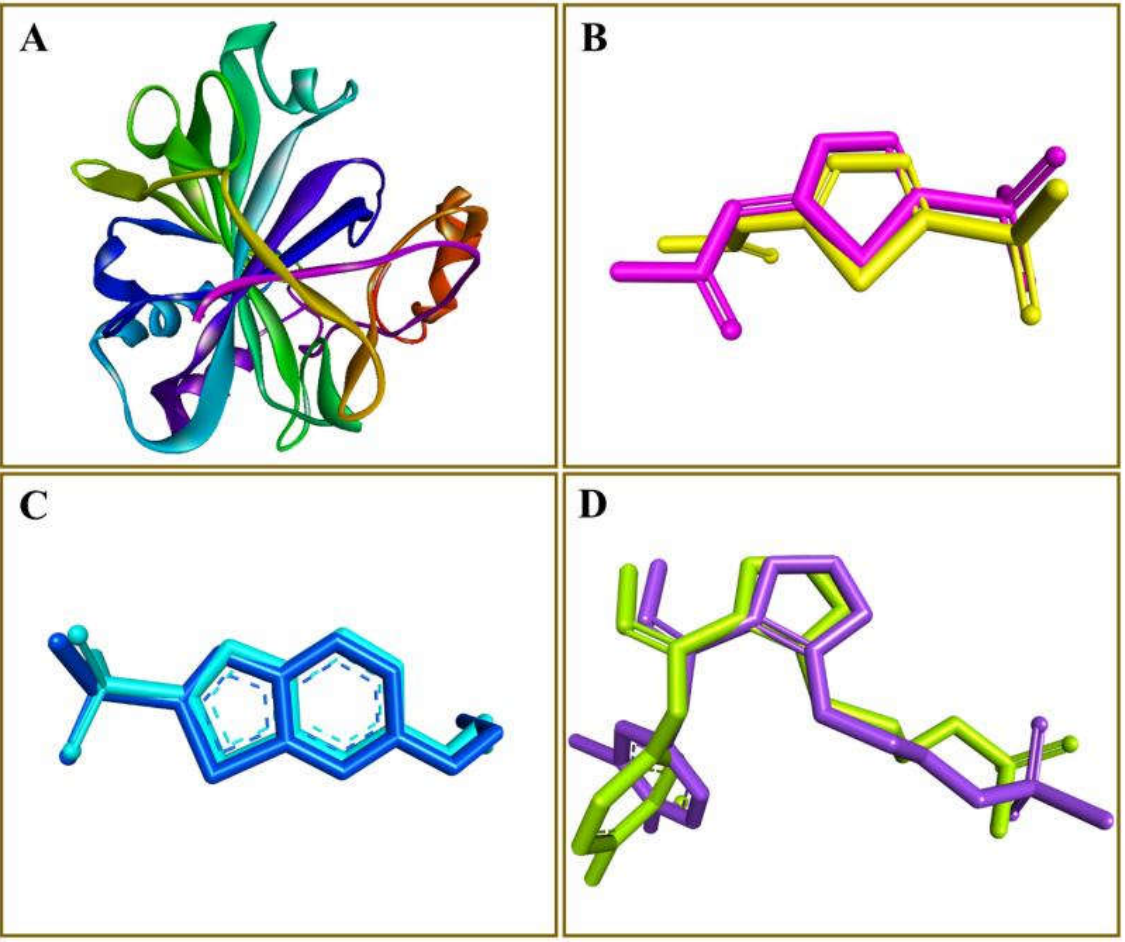
Figure 3. Validation of the docking protocol. The carbonic anhydrase protein is shown as a ribbon ( A ), whereas the co-crystallized ligands along with docked conformations of acetazolamide ( B ), ethoxzolamide ( C ), and epacadostat ( D ) are presented in a stick style.